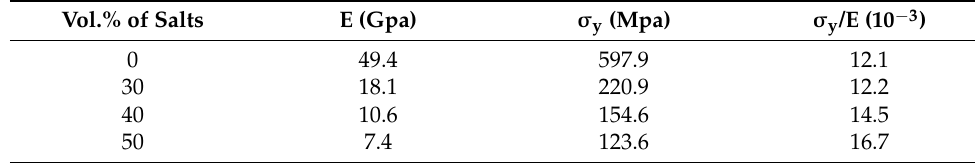
Table 3. Mechanical properties of Ti64 and Ti64/20Ag